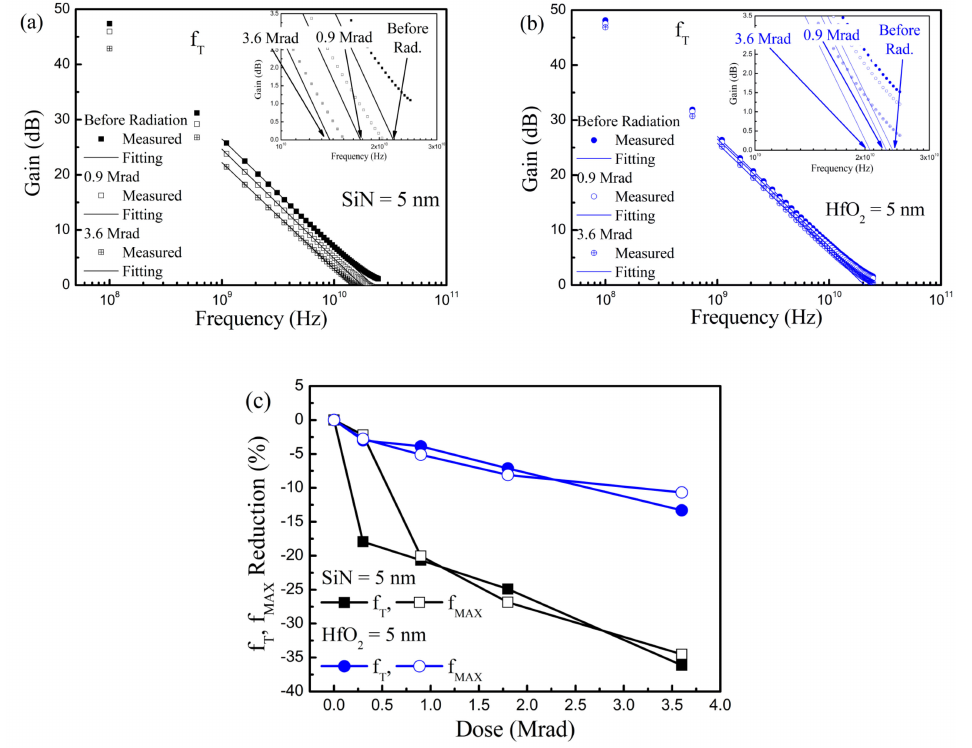
Figure 7. Radio frequency performance degradation induced by γ -ray radiation. Cut-o ff frequency characteristics before and after the γ -ray radiation in GaN-based MIS-HEMTs for a 5 nm-thick: ( a ) SiN; ( b ) HfO 2 gate insulator. ( c ) Cut-o ff frequency and maximum oscillation frequency reduction vs. irradiated γ -ray